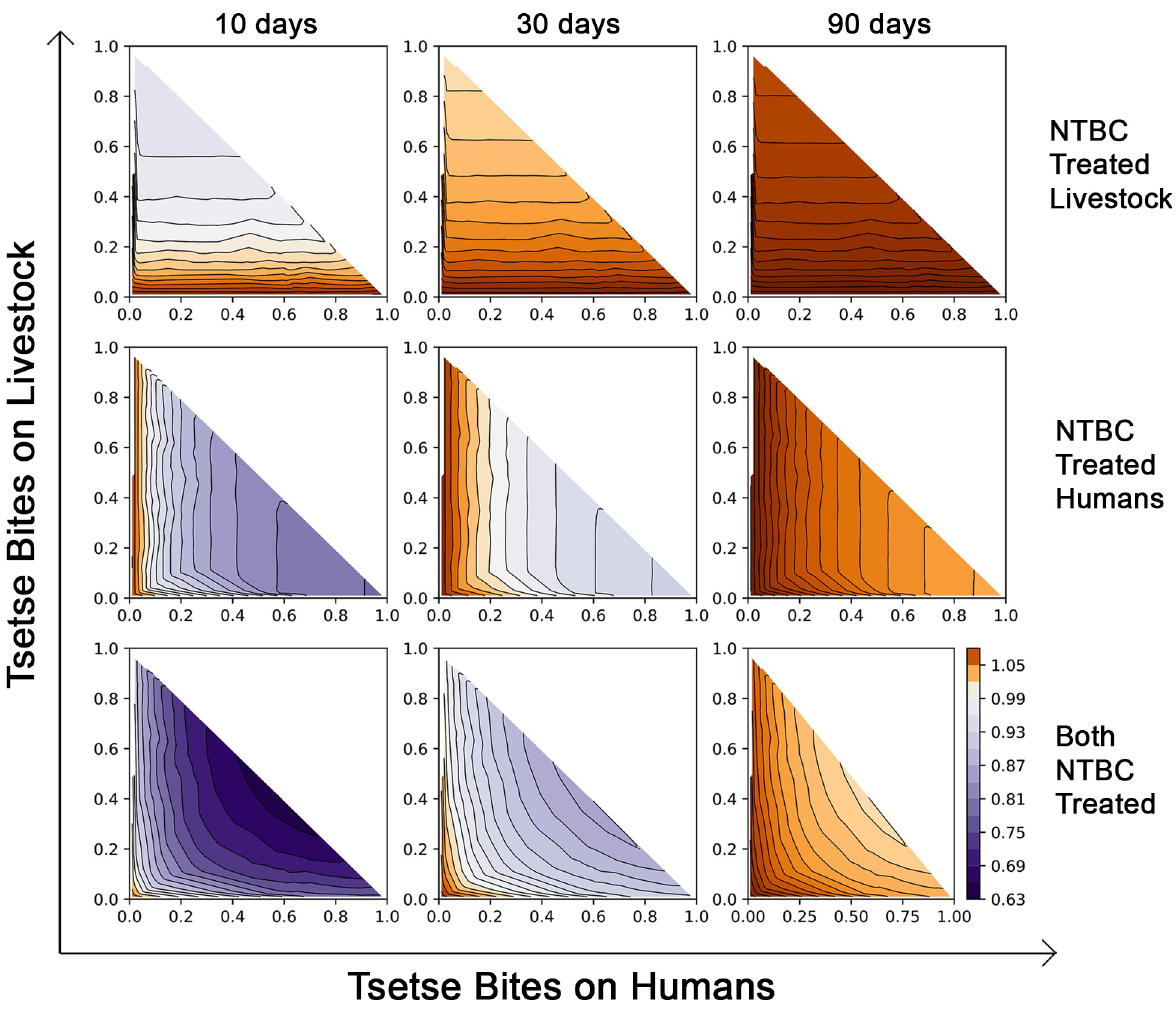
Fig 5. Impact of NTBC application on the effective reproduction number of T . brucei , ( R e > 1 in brown and R e < 1 in purple). Top row: NTBC applied to livestock only; Middle row: Only humans are treated with NTBC; Bottom row: Simultaneous treatment of both livestock and humans with NTBC. Treatments are modelled with NTBC application every 10 days (left column), every 30 days (middle column), or every 90 days (right column). The axes denote the proportional split of bloodmeals taken by local tsetse populations when humans, livestock, and wildlife are potential hosts (where proportion of bites on wildlife are 1 - (bites on humans + bites on livestock)). NTBC,